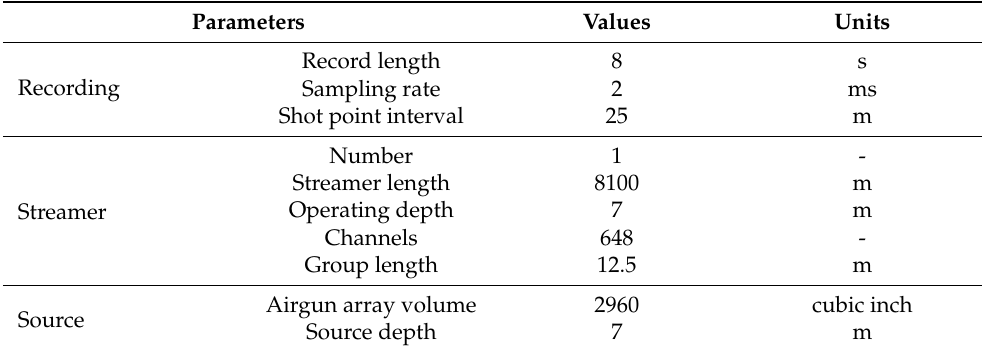
Table 1. Reflection seismic data acquisition